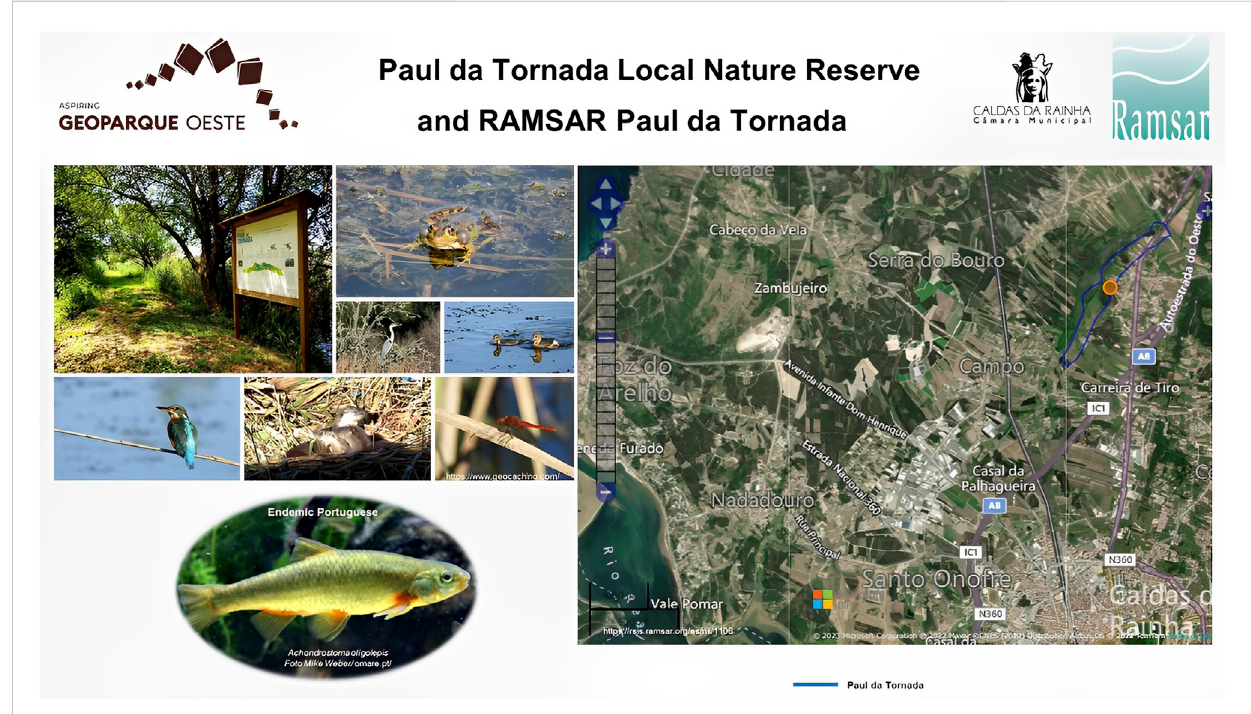
FIGURE 4 Ramsar Paul da Tornada site. Source: produced by the authors.